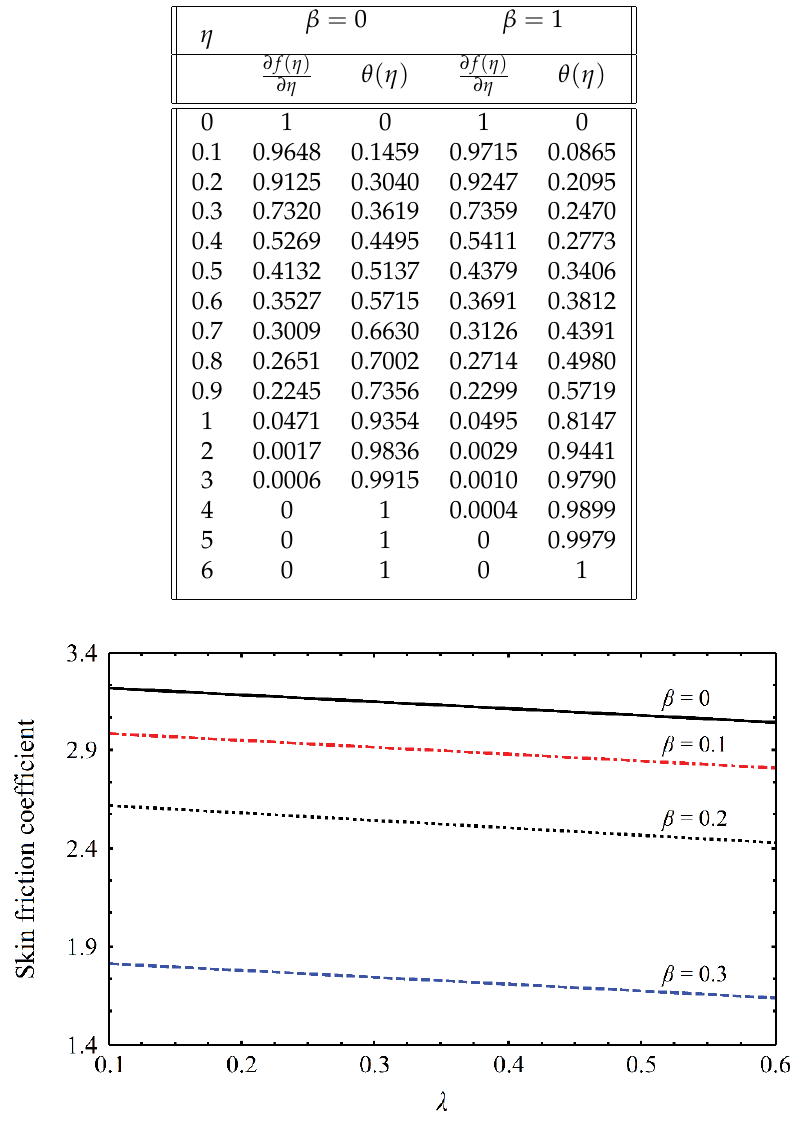
Figure 1. Variation of the Skin friction coefficient versus Casson fluid parameter at some different melting